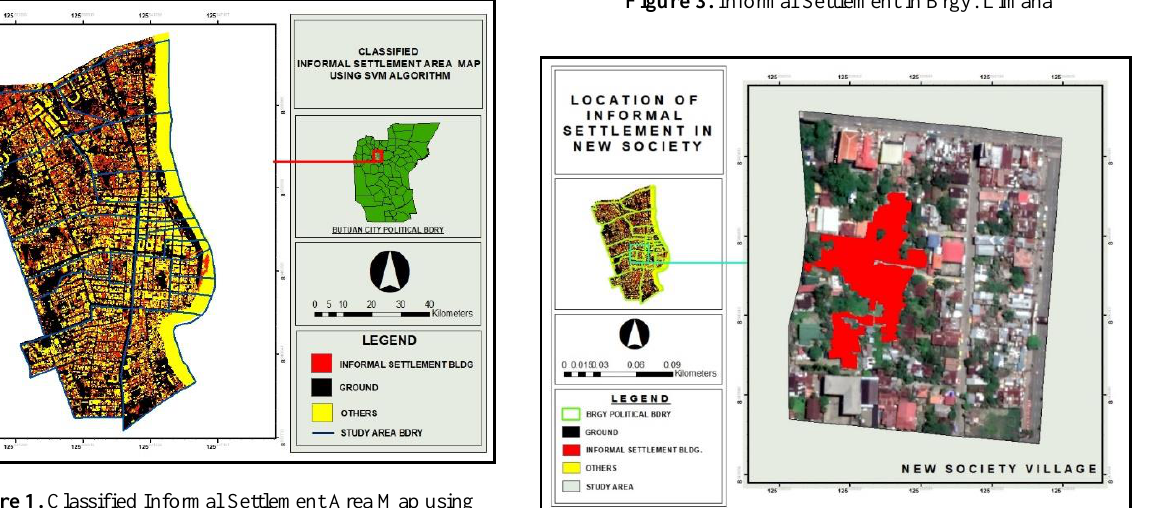
Figure 4. Informal Settlement in Brgy. New Society Village